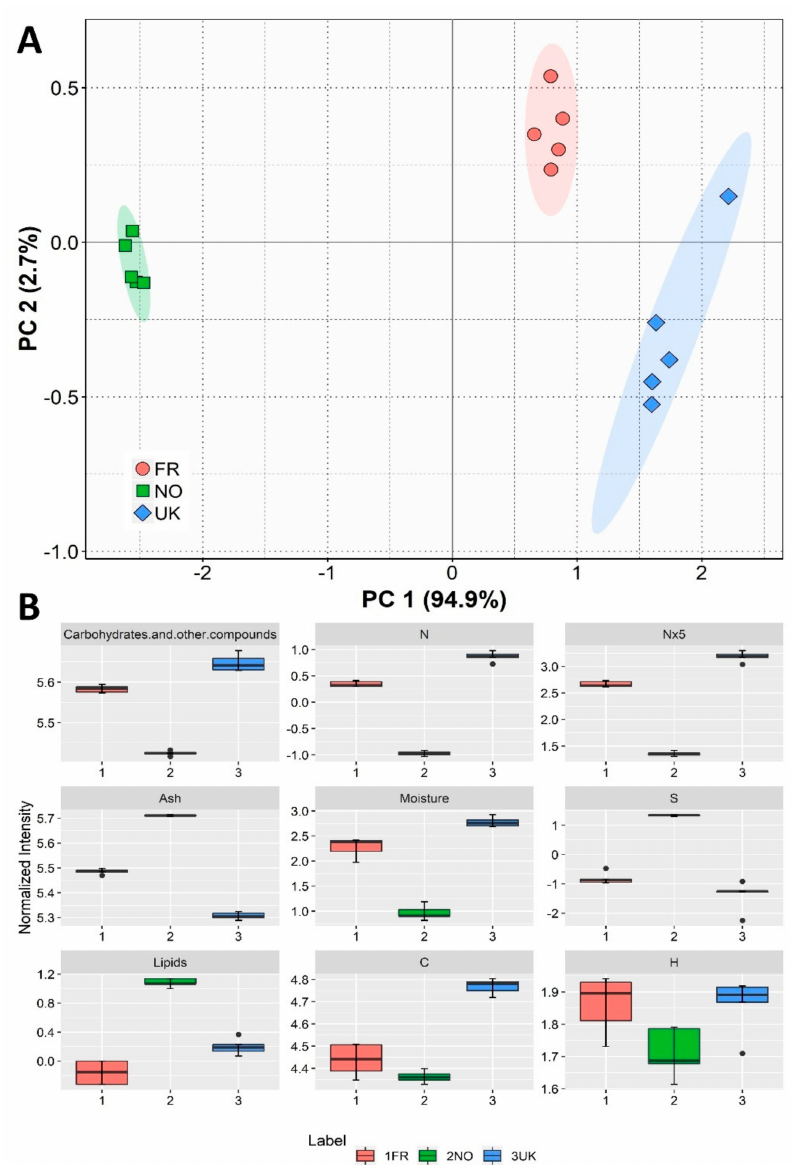
Figure 1. Sample origin discrimination based on biochemical composition. ( A ) Principal component analysis (PCA) score plot of elemental and biochemical traits of samples of Saccharina latissima from three di ff erent origins (FR—France, NO—Norway, UK—United Kingdom). ( B ) Box plots of each compositional trait used to calculate PCA, ranging from major to lesser contributors, for Component 1 of the PCA (left to right, top to bottom; C: carbon; H: hydrogen; N: nitrogen; N × 5: estimated protein content; S: